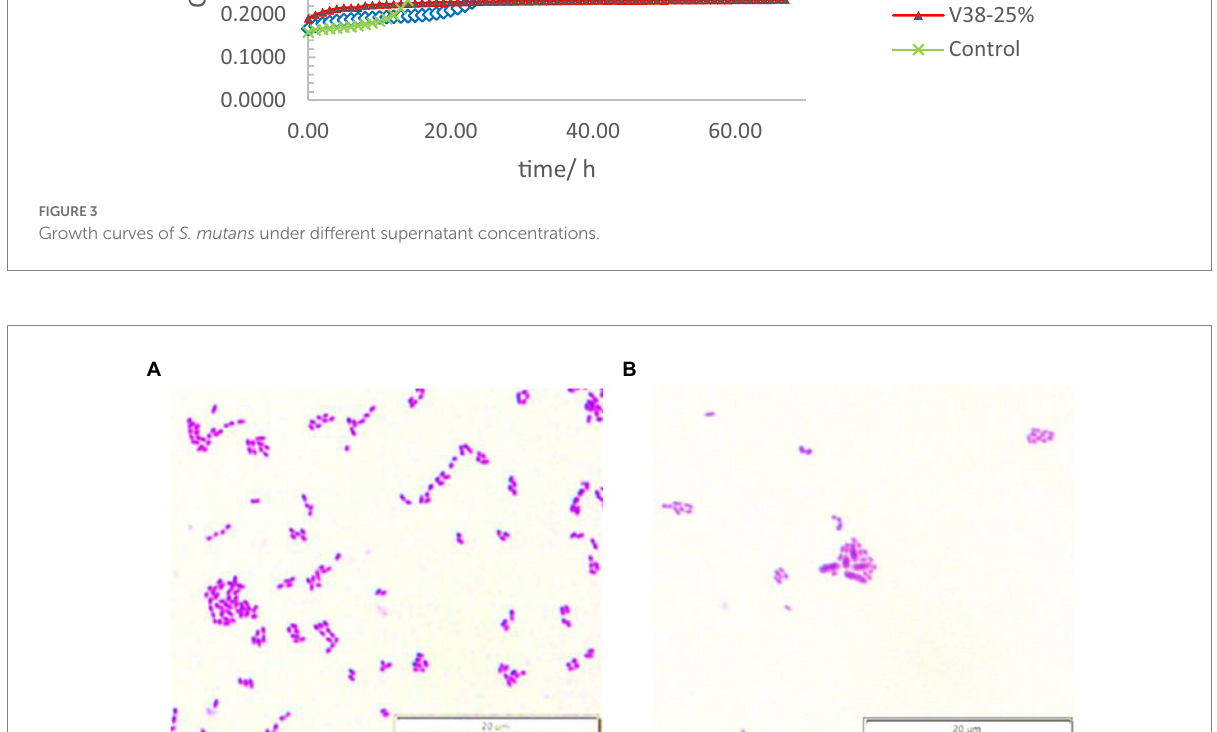
FIGURE 4 S. mutans adherence to chamber slides. (A) S. mutans control; (B) the